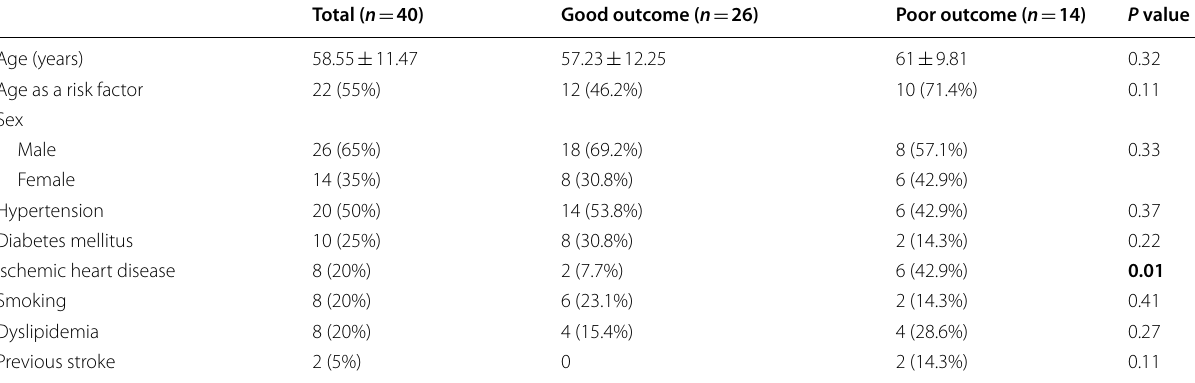
Data expressed as frequency (percentage), mean (SD). P value was significant if < 0.05. n :